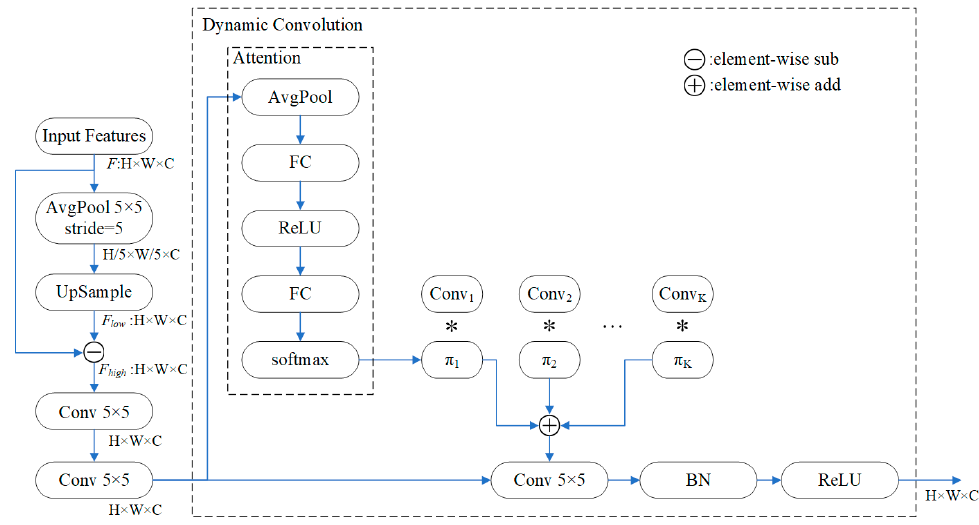
Figure 3. Structure of the feature enhancement module.